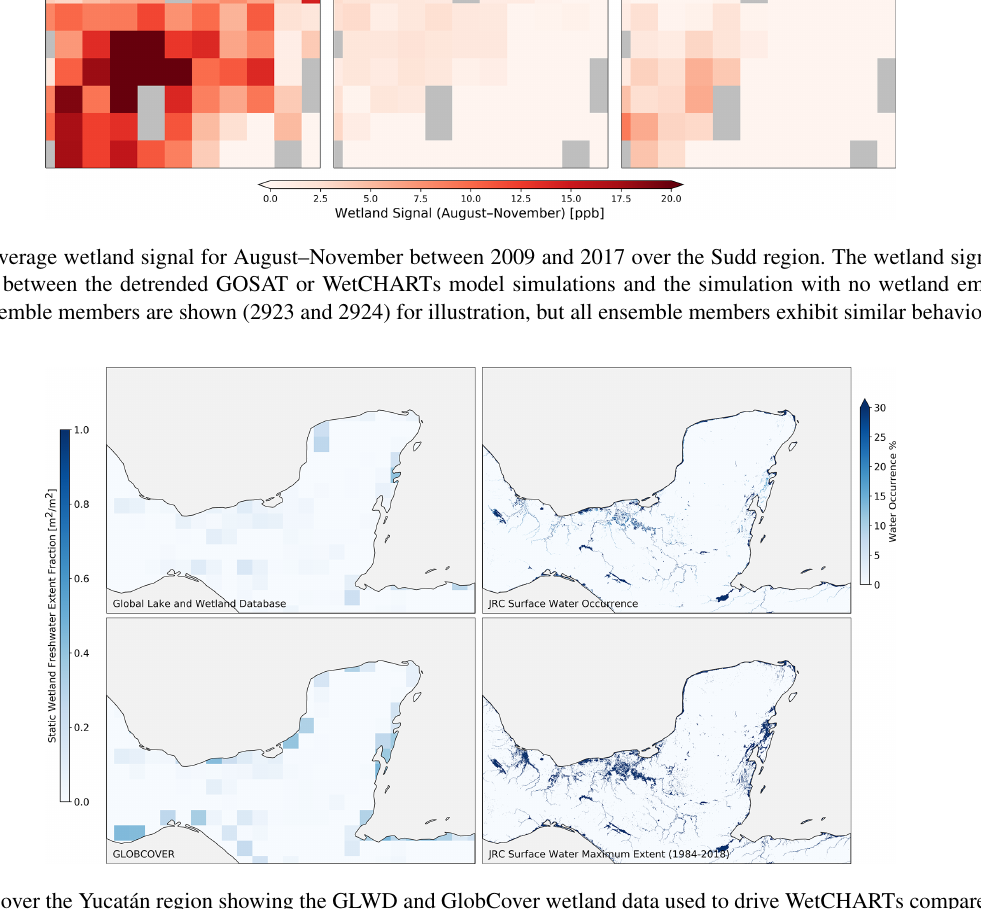
Figure 15. Maps over the Yucatán region showing the GLWD and GlobCover wetland data used to drive WetCHARTs compared to the JRC surface water occurrence and maximum extent datasets. Neither of the datasets driving WetCHARTs represents the large Tabasco–Campeche wetland complexes in the centre of this